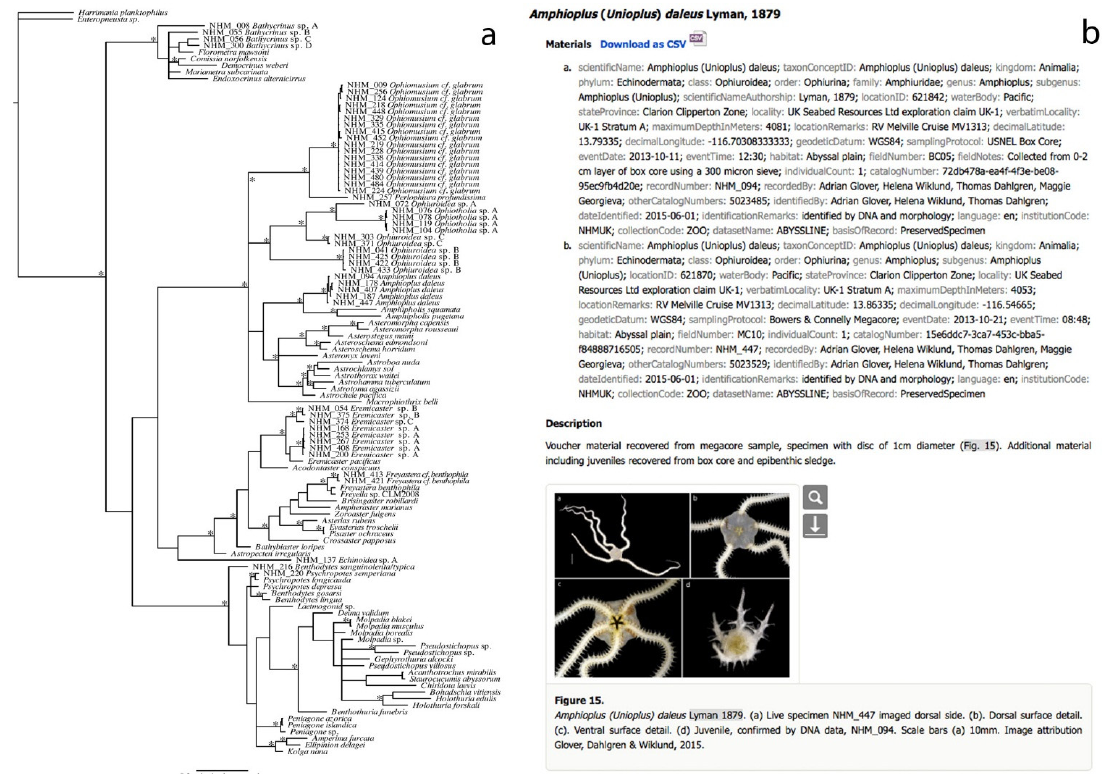
Figure 17. Abyssal plain DNA Taxonomy. ( a ) Phylogenetic analysis is used to generate statistically-supported species hypothesis (here by example a working tree for echinoderms from